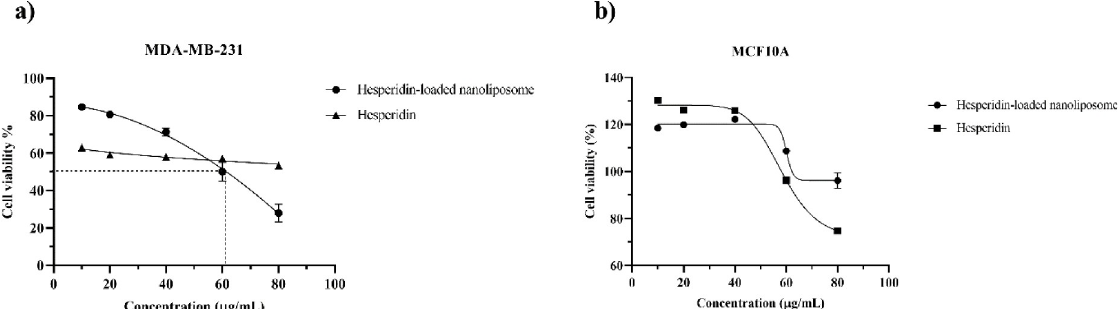
Fig 5. The cytotoxicity assay of hesperidin-loaded nanoliposomes and hesperidin against the MDA-MB-231 (a) and the MCF10A (b) cell lines using the MTT assay method. Dotted lines on the graph show the IC 50 value.